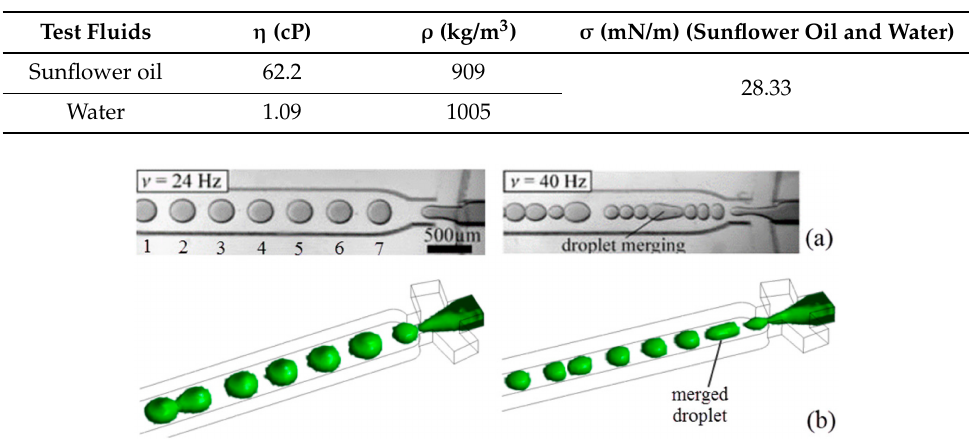
Figure 2. Comparison of results at rotation frequency of 24 Hz ( Bo = 0.09) and 40 Hz ( Bo = 0.25) between ( a ) experiments from Haeberle et al. [37] (reprinted with permission from Springer) and ( b ) our simulation using rotating flow-focusing two-phase microsystem where water is used as dispersed phase and silicone oil as continuous phase, Ca CP = 0.16. Table 3. Comparison of average size of each droplet between simulation and experimental results (Numbers 1–7 refer to the seven droplets generated in Figure 2a).